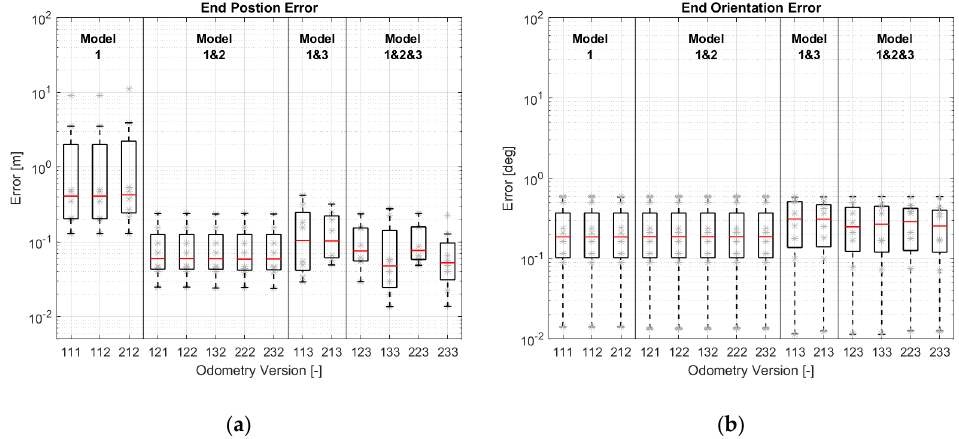
Figure 24. Real driving results of different odometry versions using a yaw rate sensor with a resolution of 0.1°/s: ( a ) End position errors; ( b ) End orientation errors.